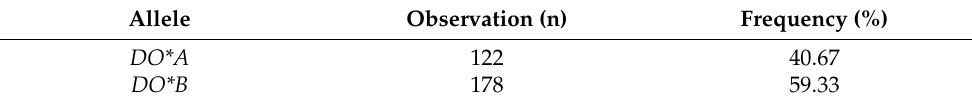
Table 2. The frequency of DO alleles in Saudi blood donors from the Jazan Province.